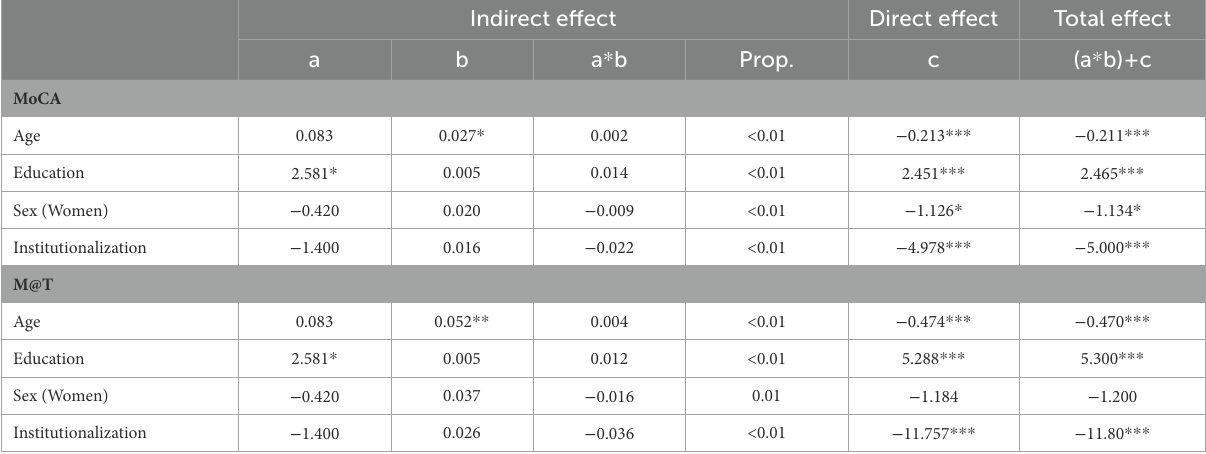
TABLE 3 Mediation analysis of the four sociodemographic predictors of cognitive performance (assessed with the MoCA and M@T) contrasted with motivational reserve as a mediating variable (assessed with the